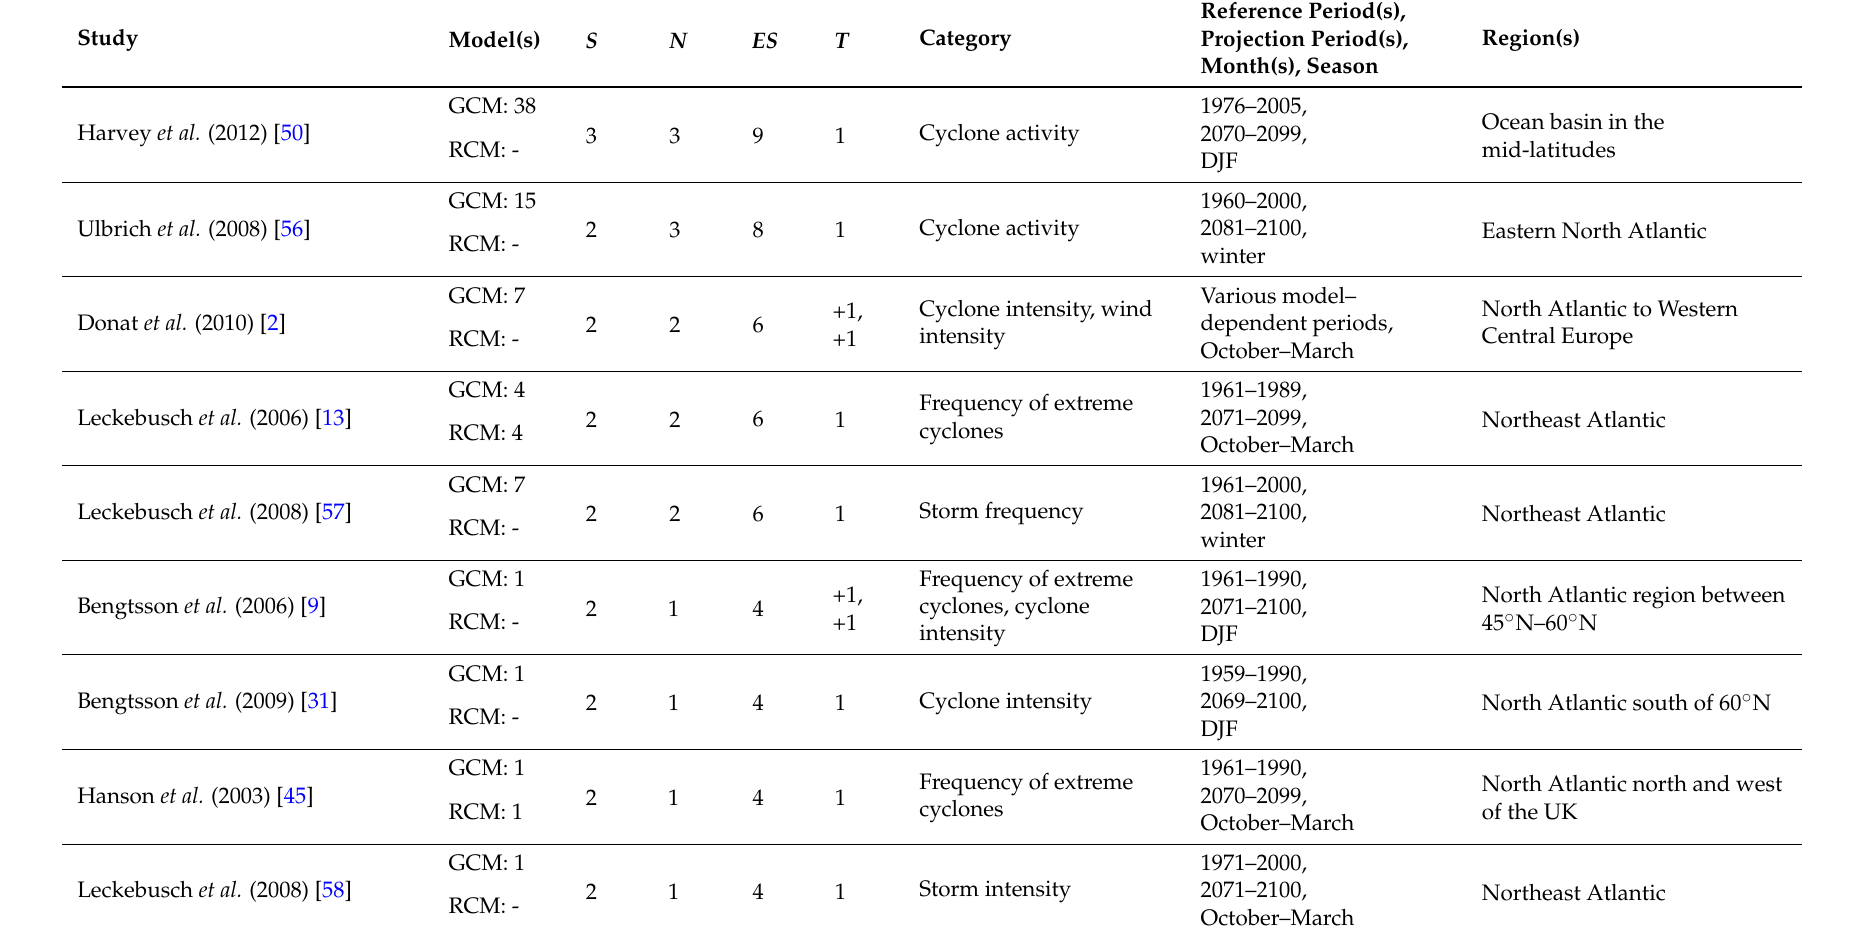
Table 2. Same as Table 1 but for the North Atlantic subregion south of 60 ˝